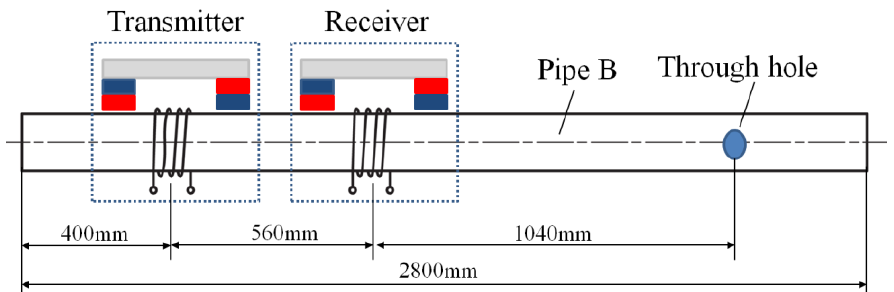
Figure 11. The specimen (pipe B) with a through hole used for defect inspection.